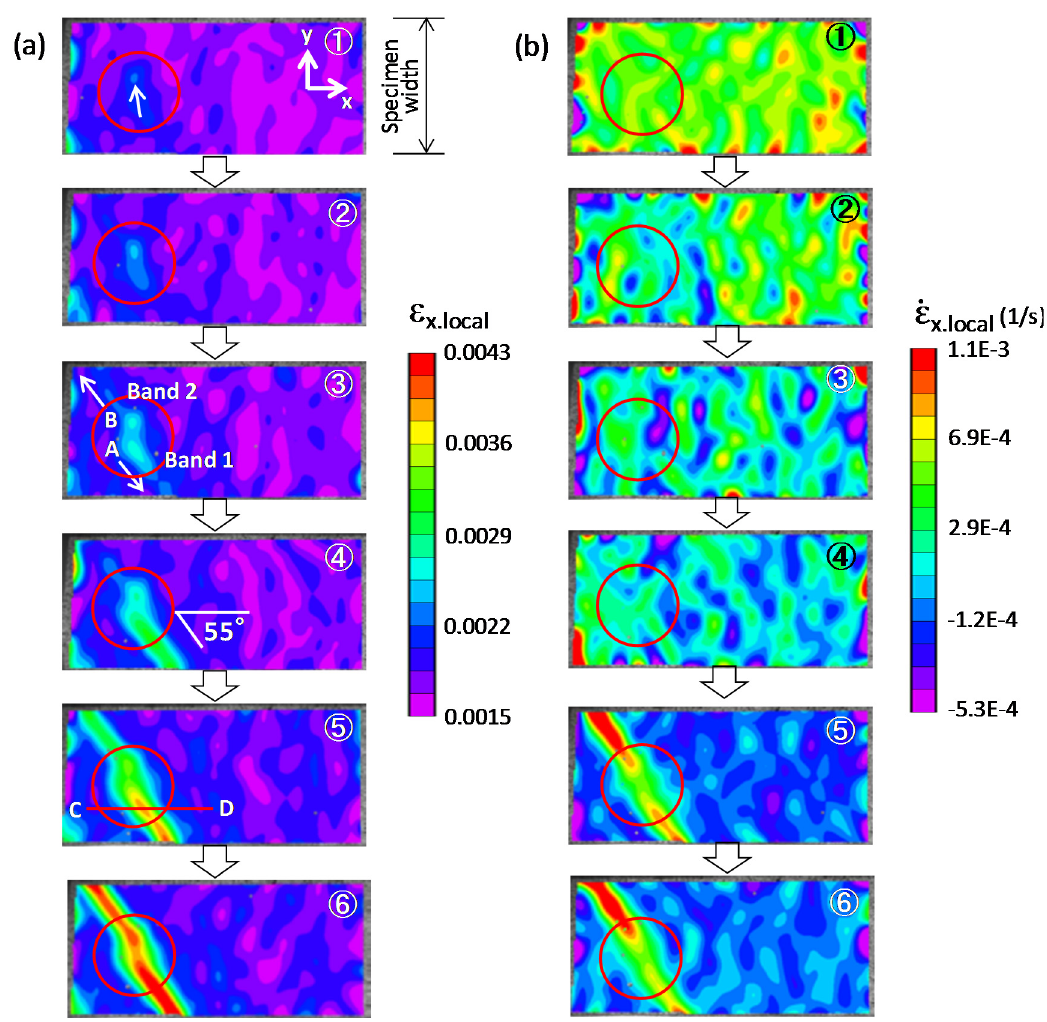
Figure 5. ( a ) Evolution of the strain field. ( b ) Evolution of the strain rate field. Global stress: 1 (cid:79) 0.86 σ up.ys.ob (318 MPa), 2 (cid:79) 0.90 σ up.ys.ob (332 MPa), 3 (cid:79) 0.93 σ up.ys.ob (345 MPa), 4 (cid:79) 0.95 σ up.ys.ob (351 MPa), 5 (cid:79) 0.99 σ up.ys.ob (364 MPa), 6 (cid:79) σ up.ys.ob (369 MPa). Time interval: 1 (cid:79) to 2 (cid:79) , 4 s, 2 (cid:79) to 3 (cid:79) , 5.5 s, 3 (cid:79) to 4 (cid:79) , 2.5 s, 4 (cid:79) to 5 (cid:79) , 1 s, 5 (cid:79) to 6 (cid:79) , 0.5s. DIC parameters: subset size, 9 pixels × 9 pixels (248 µ m × 248 µ m), step, 5 pixels (138 µ